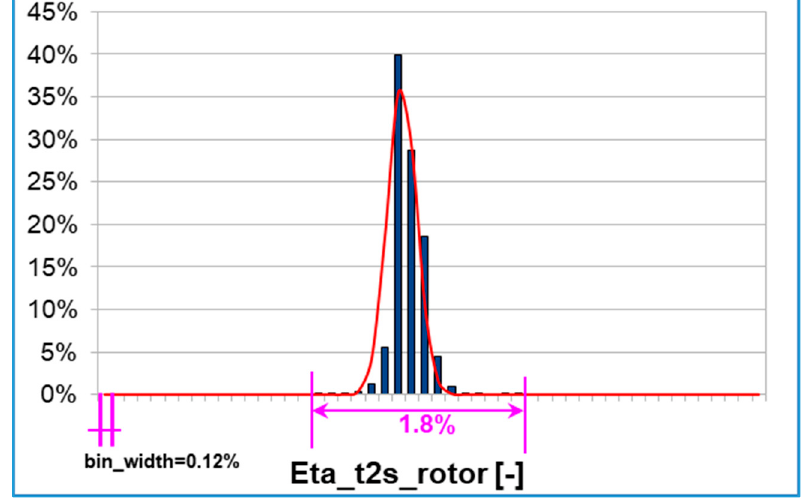
Figure 8. SB-UQ: rotor efficiency probability bars (in blue) and related Gaussian trend (red line).